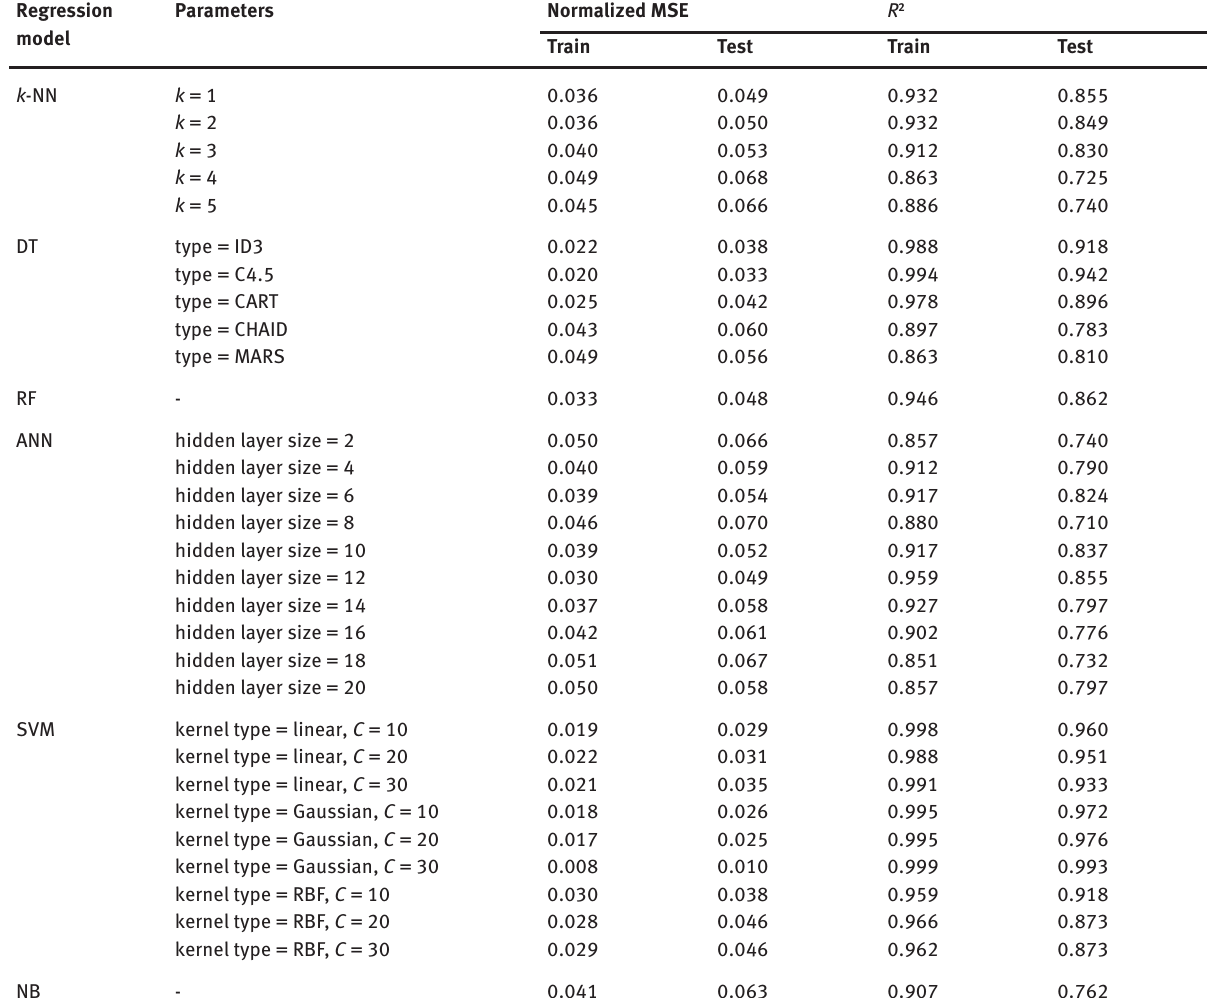
Table 4: Performance evaluation of different models in prediction of the story drifts (parameters of each model are demonstrated in the text). Regression